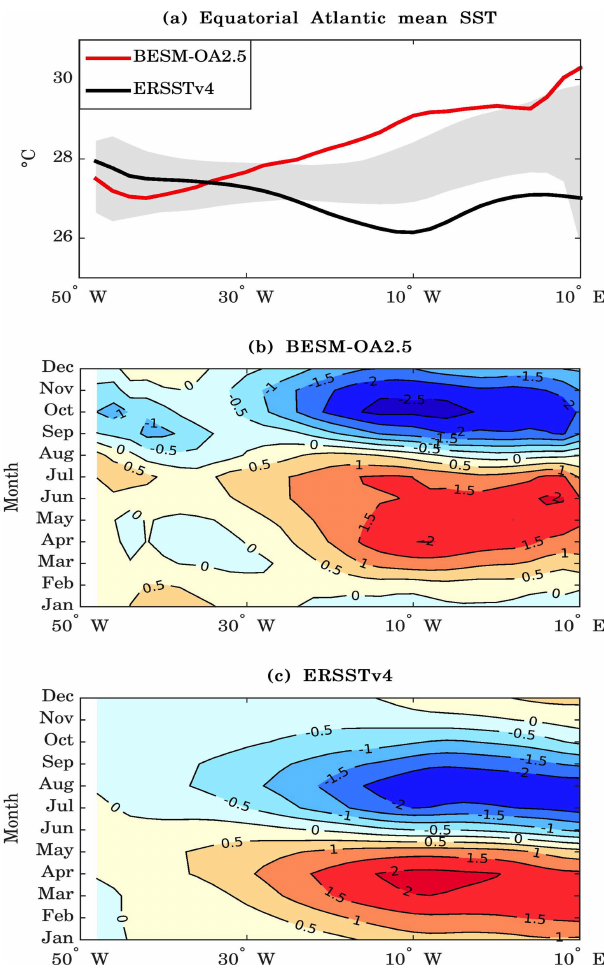
Figure 12. As Fig. 11, but for the Atlantic Ocean.